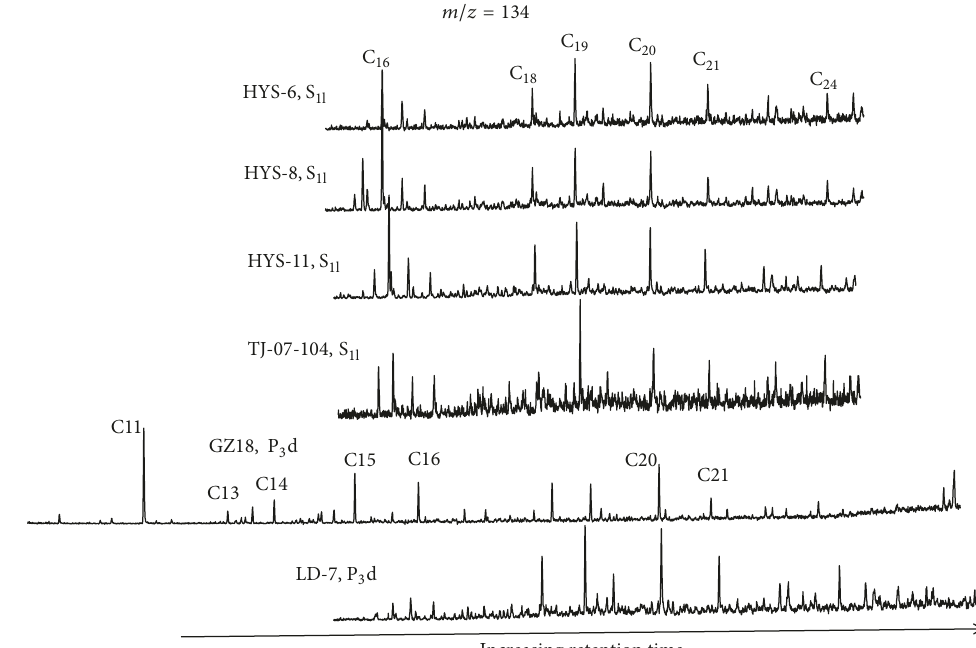
Figure 3: GC-MS selected ion mass chromatograms ( 𝑚/𝑧 134) for extractable organic matter from source rocks from Lower Silurian (HYS-6, HYS-8, HYS-11, and TJ-07-104) and Upper Permian (GZ18 and LD-7) showing abundant aryl isoprenoids.